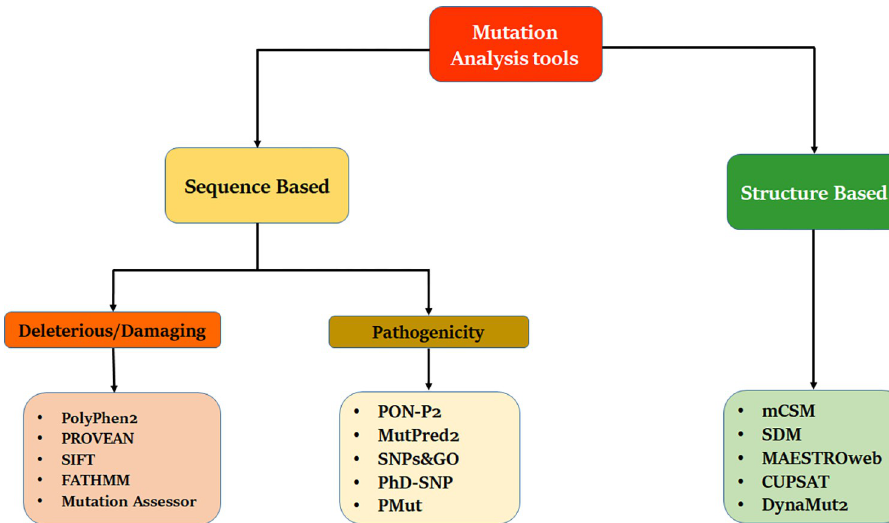
Fig 1. Graphical representation of tools used in this study for